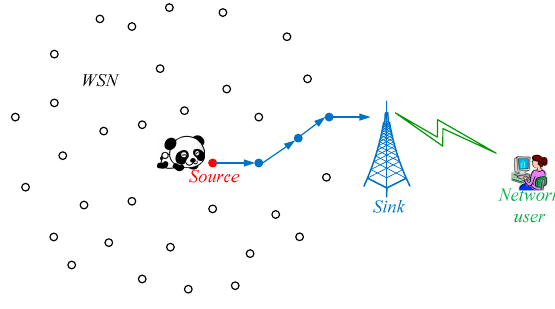
Figure 1. Network model.